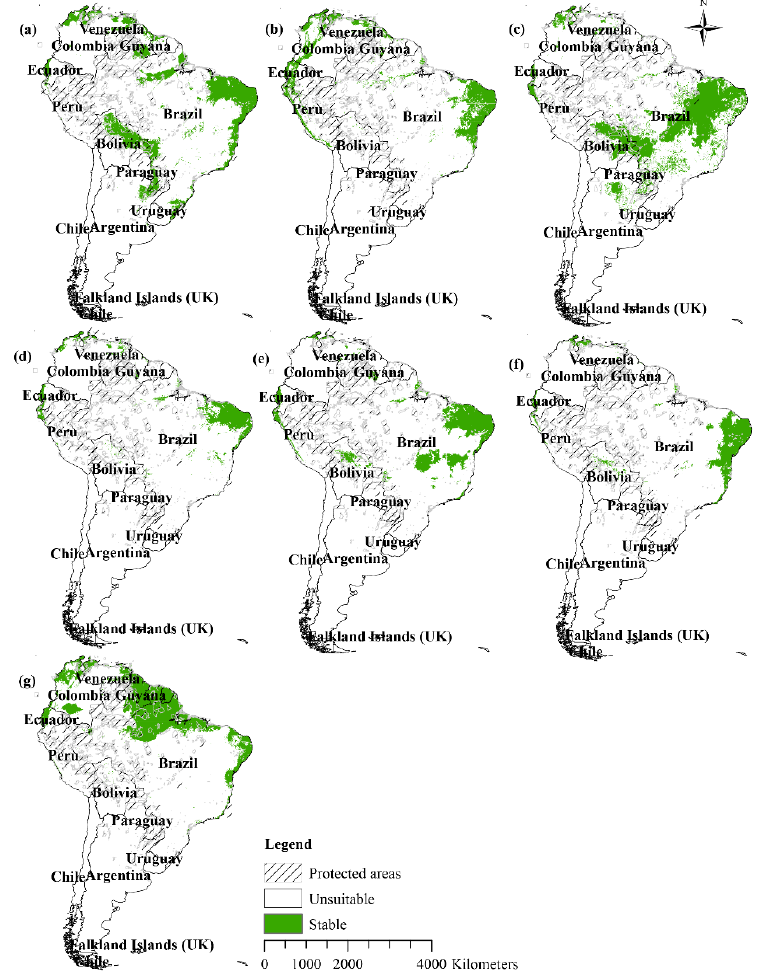
Figure 2. The current distribution of the seven Nymphaea species in South America: ( a ) N. amazonum , ( b ) N. ampla , ( c ) N. jamesoniana , ( d ) N. lasiophylla , ( e ) N. lingulata , ( f ) N. pulchella , and ( g ) N. rudgeana .